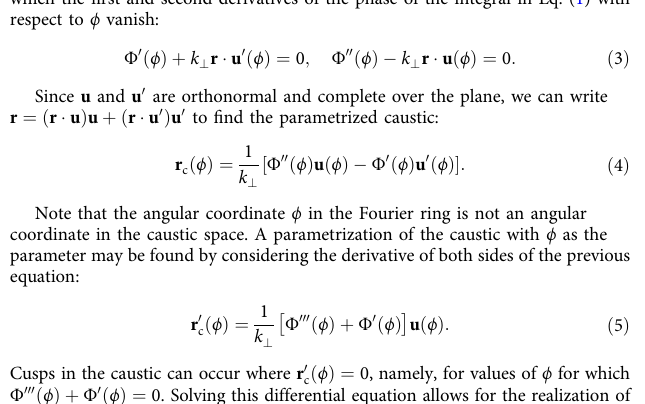
Methods Experimental setup . Figure 4 shows the experimental setup. A frequency- doubled cw Nd:YVO 4 laser beam with wavelength λ 0 = 532 nm is expanded in a plane wave, illuminating a phase-only full HD SLM ‘ Holoeye HEO. ’ We address a pre-calculated phase pattern to the SLM that allows encoding the real space amplitude and phase simultaneously on a single phase-only modulator 41 . There- fore, in the common focal plane of the lenses L1 ( f = 385 mm) and L2 ( f = 38 mm) an appropriate fi lter in Fourier space is necessary (FF). The desired light fi eld forms in the image plane of the modulator. A movable microscope objective (MO), Olympus MPLN with a magni fi cation of 10 and numerical aperture of 0.25, together with a camera, iDS UI-3370CP-M-GL, constitute the imaging system, capable of observing the propagation of a light fi eld. A second expanded beam, a plane wave, serves as a reference beam and can be switched on for phase mea- surements using a shutter (S). To recover the spatial phase, a standard digital holographic method is applied, that is based on the superposition of the signal beam with a slightly tilted reference beam 42 .